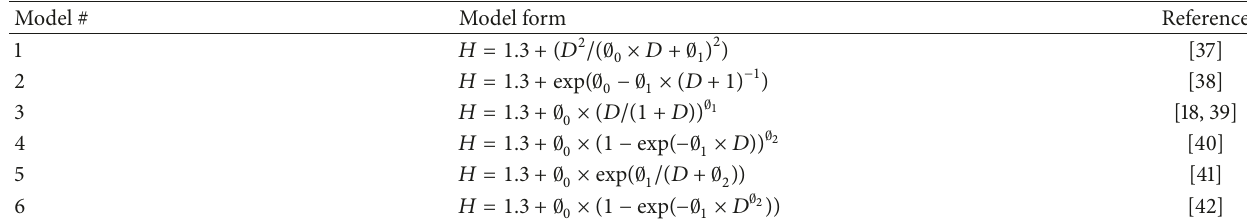
Table 2: Height base model forms.